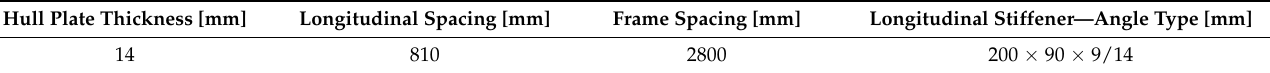
Table 8. Dimension of the LNG carrier hull structure for Model